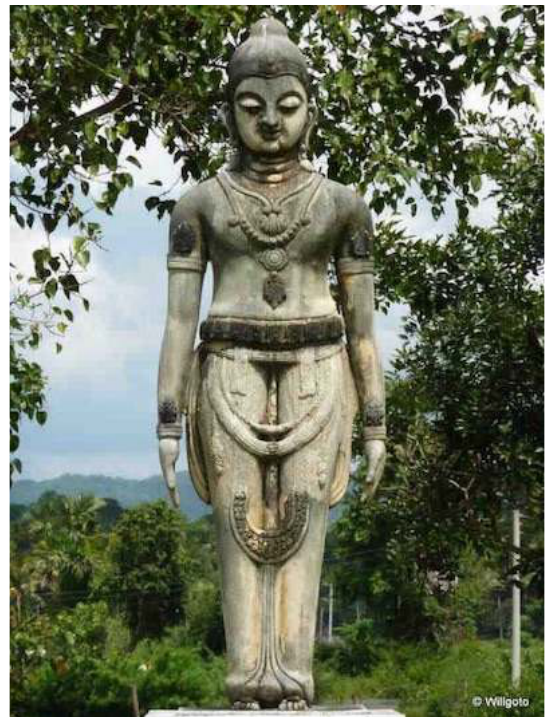
Source: http://www.willgoto.com/images/Size3/